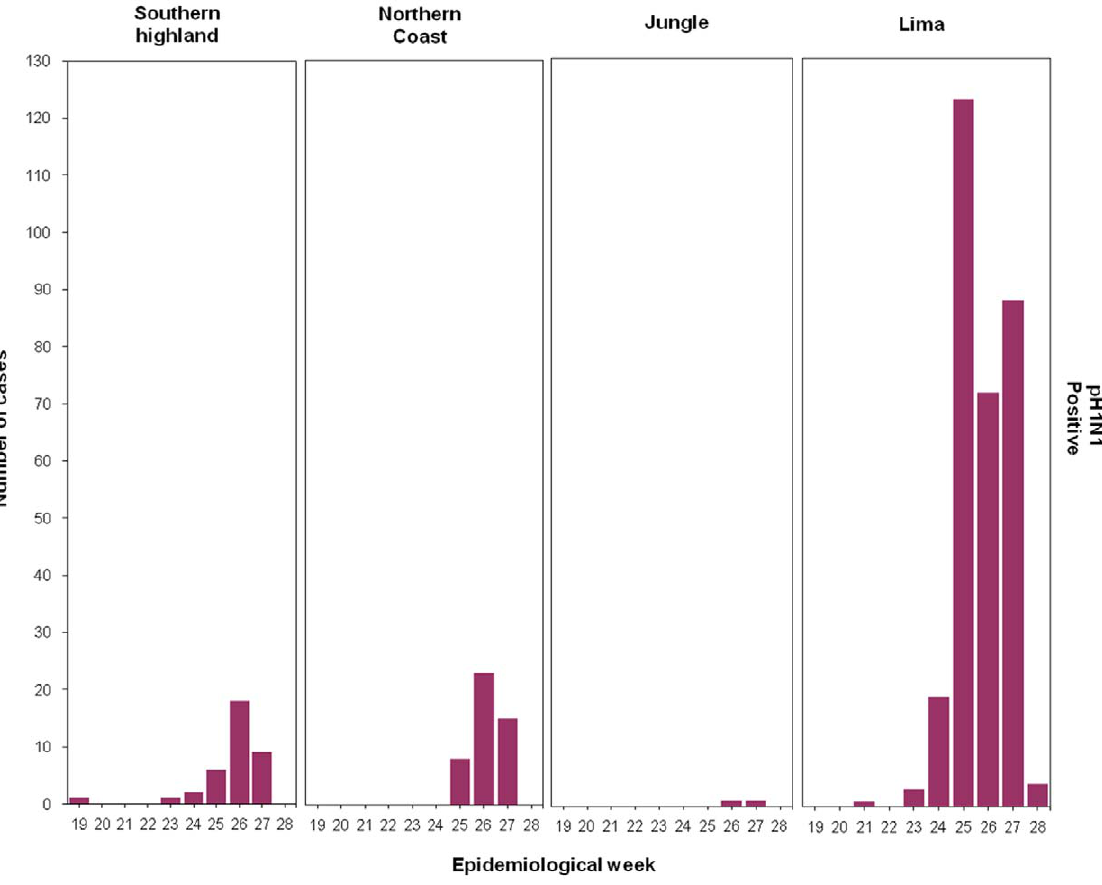
Figure 3. Distribution of Influenza A pH1N1 among regions according to epidemiological week. Peru, May 10 January to July 13, 2009.